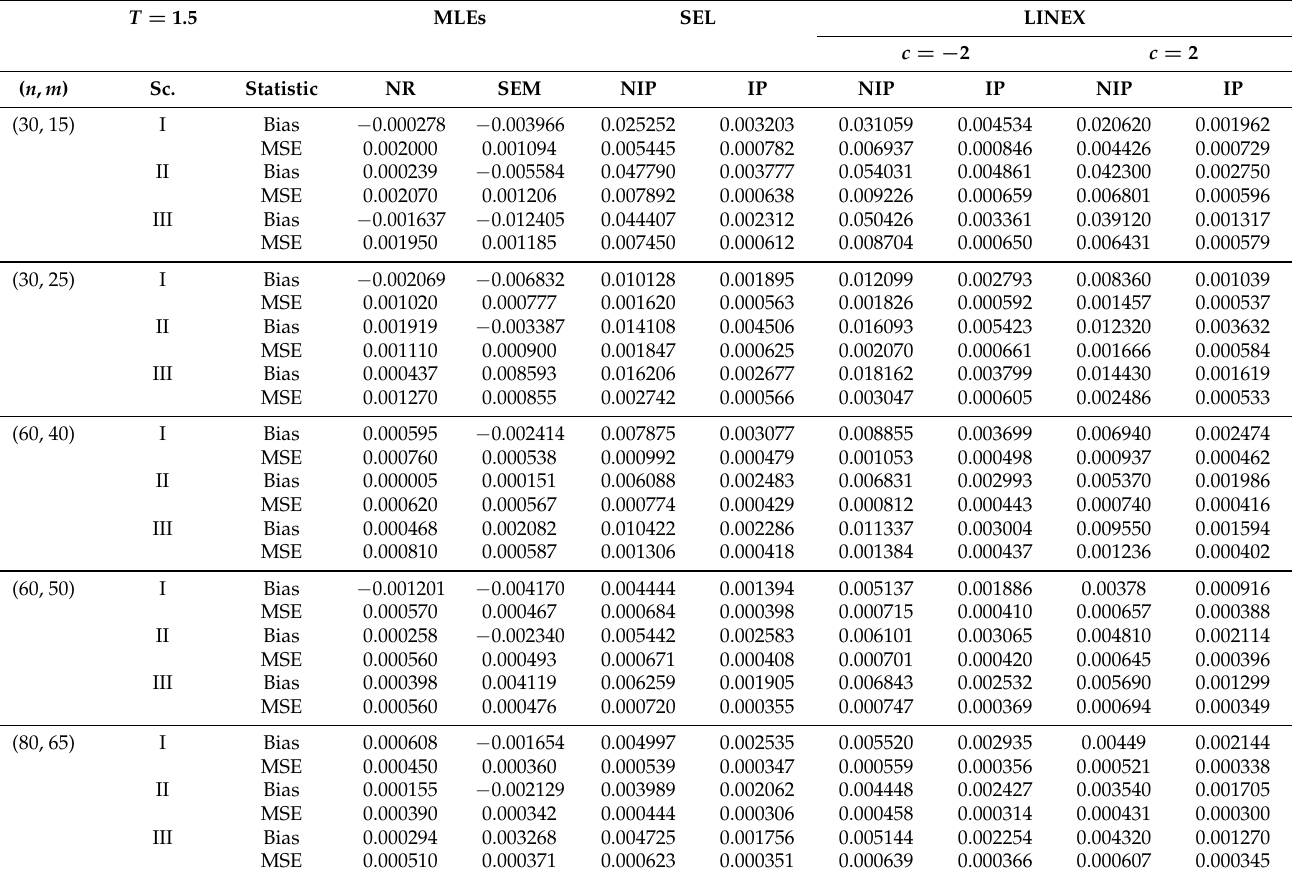
Table 10. Average values of the biases (first row) and MSEs (second row) for MLEs and Bayes estimators of λ under informative prior (IP) and noninformative (NIP) prior and different censoring schemes, when ( θ 1 , θ 2 , λ ) = (0.05, 0.06, 1.8).